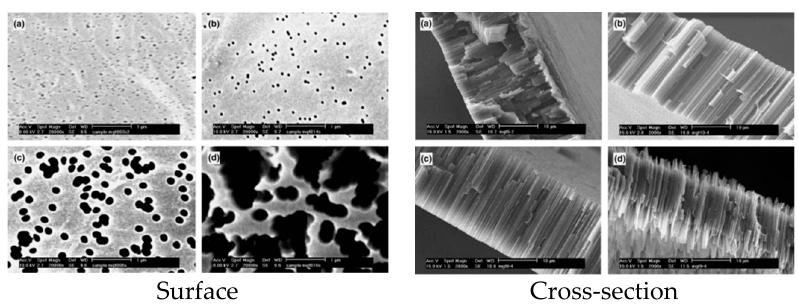
Figure 13. Scanning electron micrograph of irradiated PVDF films etched with KMnO 4 0.25 mol L − 1 solution in KOH 9 mol L − 1 at: (a) 55 °C, (b) 65 °C, (c) 75 °C and (d) 85 °C. The fluence is 4.7 × 10 9 cm − 2 (55 °C) and 9.5 × 10 8 cm − 2 for the other conditions. Etching time is ( Left ) 1 h and ( Right ) 3 h, adapted from reference [248] .